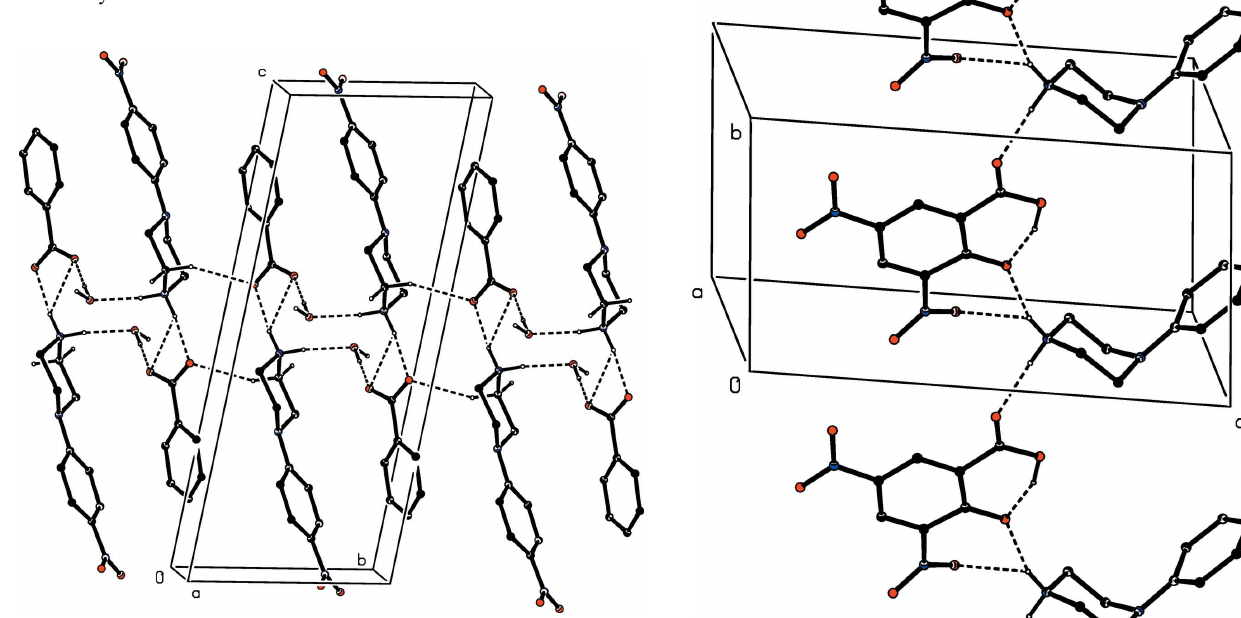
Figure 4 Part of the crystal structure of compound (I) showing the formation of a chain of hydrogen-bonded rings running parallel to the [110] direction. Hydrogen bonds are drawn as dashed lines and, for the sake of clarity, the H atoms bonded to those C atoms that are not involved in the motif shown have been omitted.